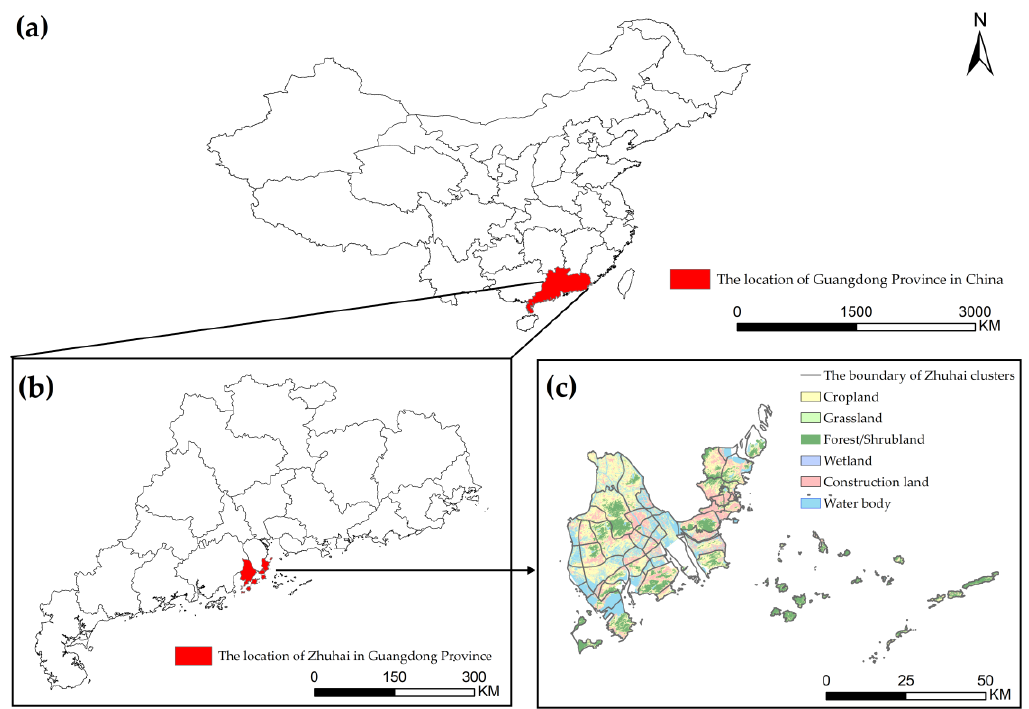
Figure 2. ( a ) The location of Guangdong Province, ( b ) The location of Zhuhai in Guangdong Province. ( c ) Distribution of planning and governance units in Zhuhai.